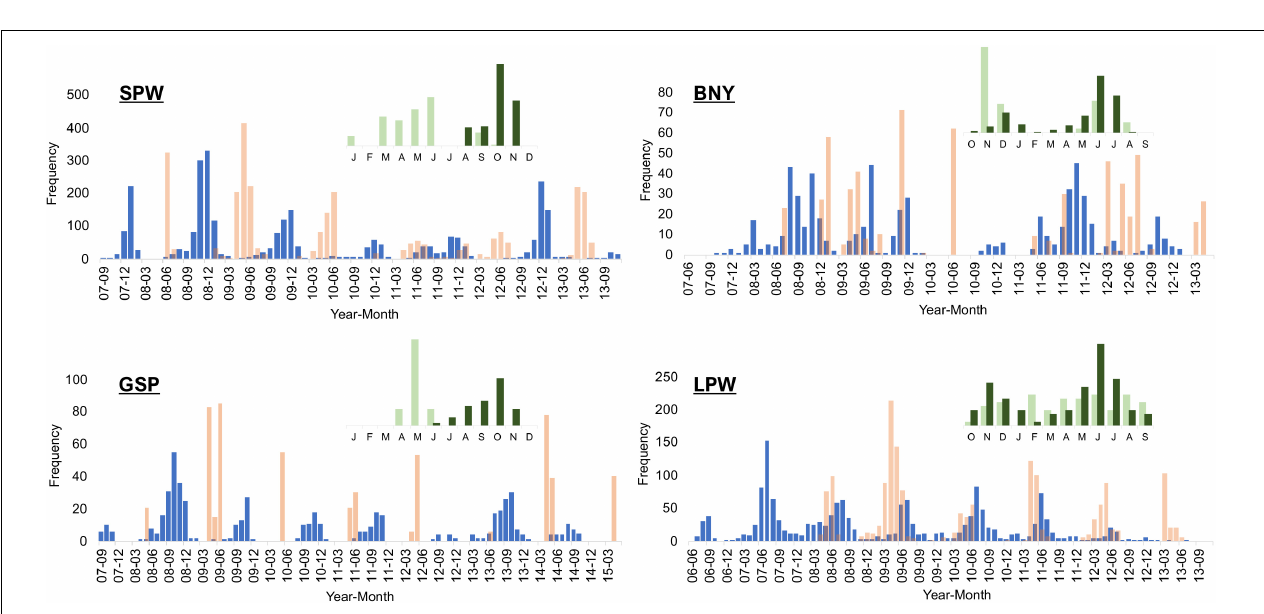
FIGURE 7 | von Bertalanffy growth model (VBGM) (V) and Gompertz (G) or logistic (L) growth curves by sex for spotwing flyingfish (SPW), bony flyingfish (BNY), greater spotted flyingfish (GSP), and limpidwing flyingfish (LPW). The optimal models were labeled in bold for each species. For LPW, data of male fish favored for Gompertz model and female for VBGM. Note here that the same juveniles are included in both male and female curves for each species.